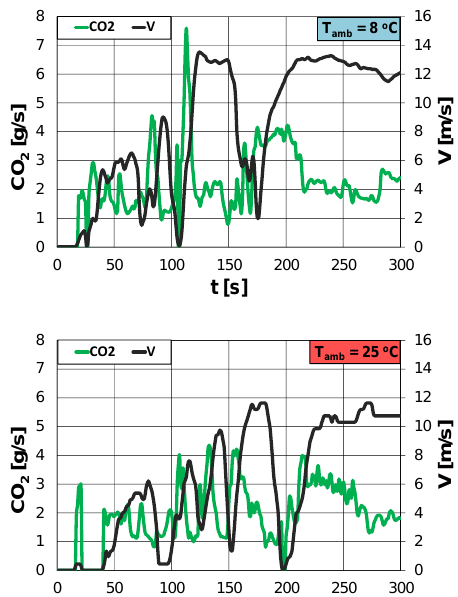
Fig. 8. Emission intensity of carbon monoxide and vehicle speed during cold start at ambient temperature of 8ºC (a) and 25ºC